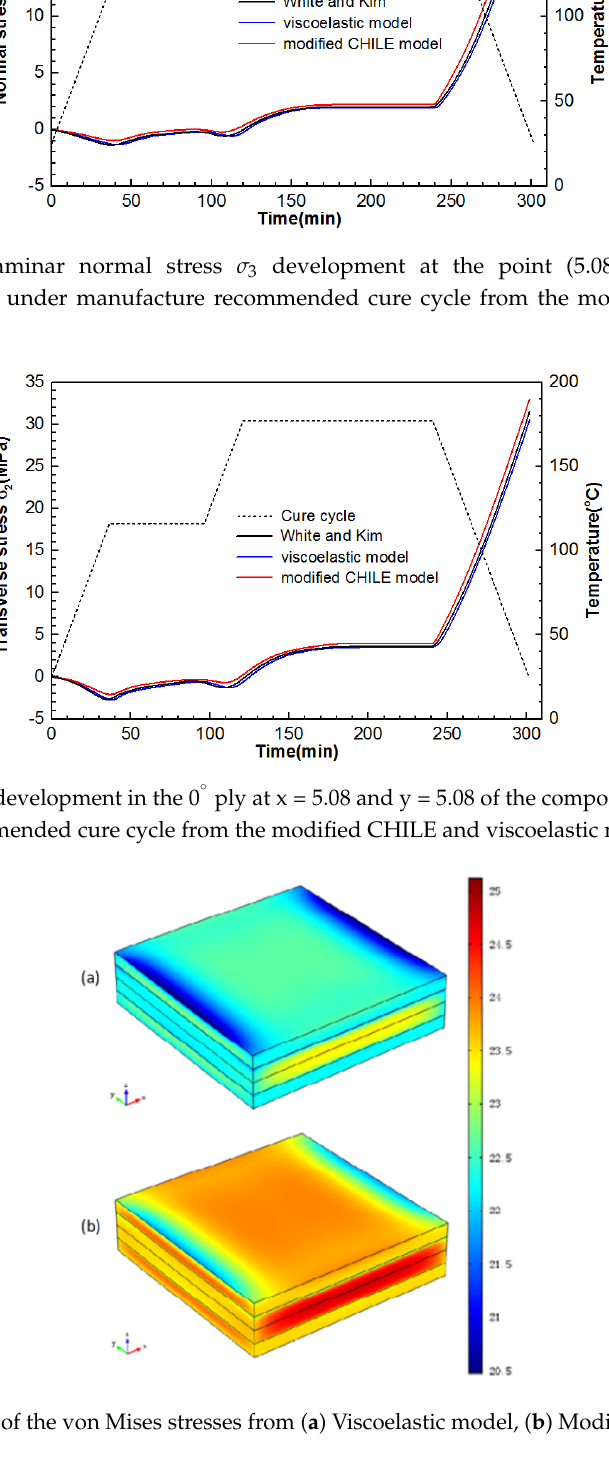
Figure 12. Contours of the von Mises stresses from ( a ) Viscoelastic model, ( b ) Modified CHILE model.